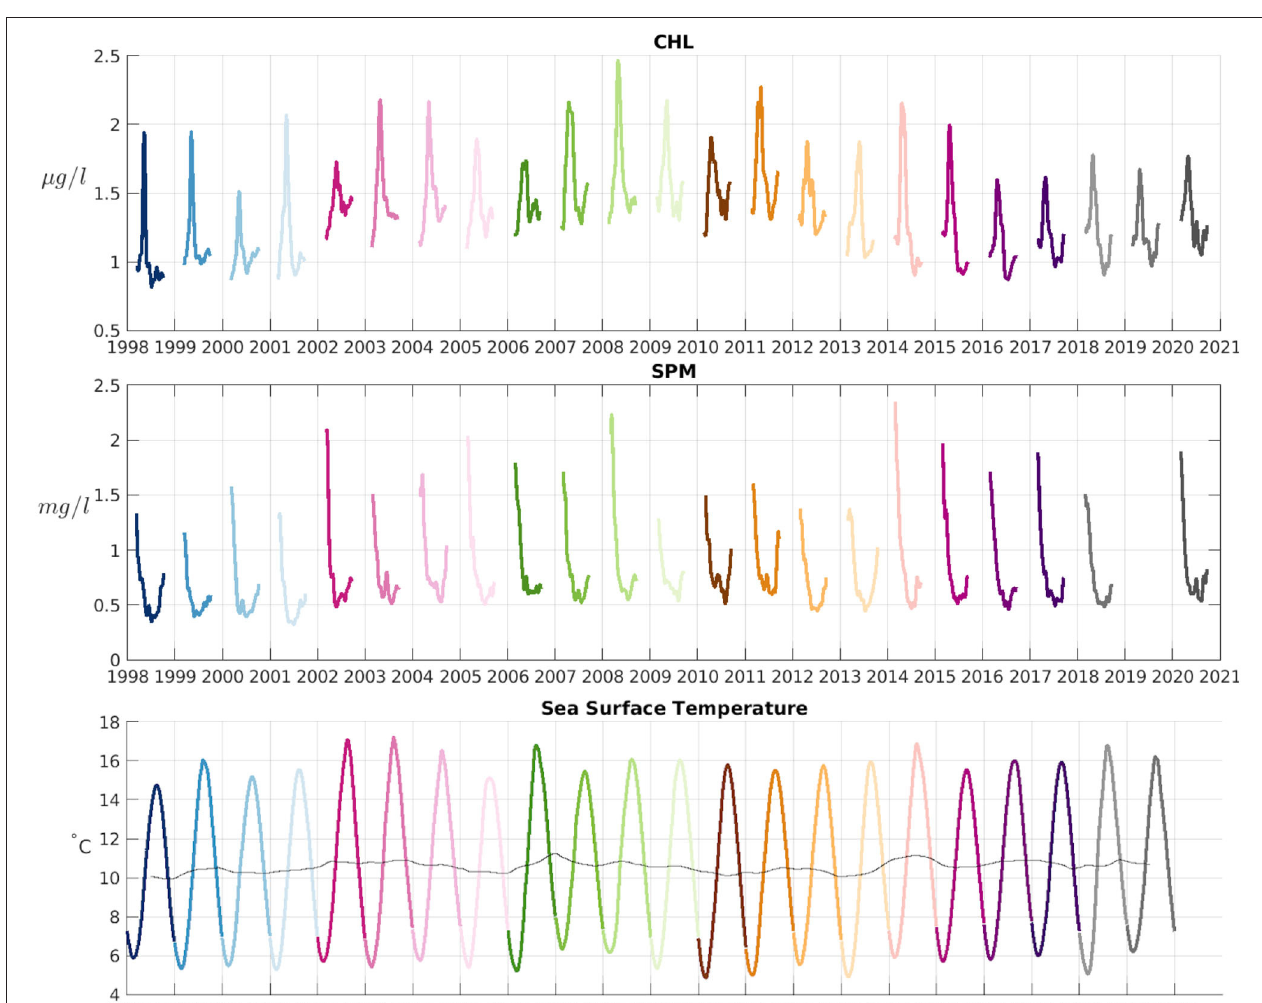
FIGURE 9 | (Top) CHL Spatial average over the whole domain of Figure 1 during the 23 years of the study. (Middle) SPM averaged over the same region. Data from December-January is not plotted. (Bottom) SST spatial average over the whole domain. The thin black line shows the 1-yr running mean. Different colors for each year are used to ease comparison between variables for a given year. This color scheme is used in other multi-year figures in this work to ease comparison.